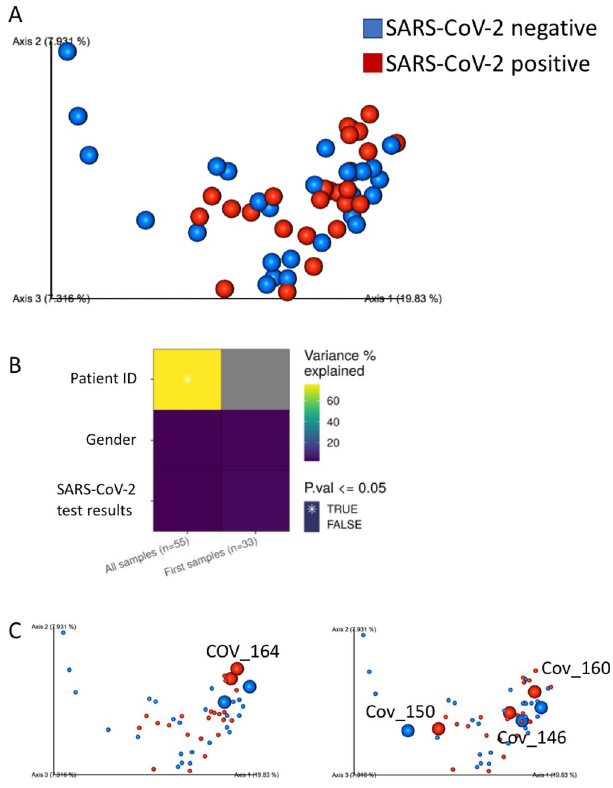
Figure 2. Personal variation has the strongest effect on nasopharyngeal microbial composition. ( A ) Unweighted UniFrac PCoA plot of all samples, colored by SARS-CoV-2 test results. ( B ) PERMANOVA analysis of microbial variance explained by subject (patient ID), gender and SARS-CoV-2 test result, using all longitudinal samples, as well as the first samples from each subject. * indicates statistical significance with p ≤ 0.05., and n is shown in brackets. ( C ) Unweighted UniFrac PCoA plot of all samples, colored by SARS-CoV-2 test results. SARS-CoV-2 positive and negative samples from specific subjects with longitude sampling are marked with increased size and labeled with the subject ID, showing clustering is driven by subject ID rather than SARS-CoV-2 test